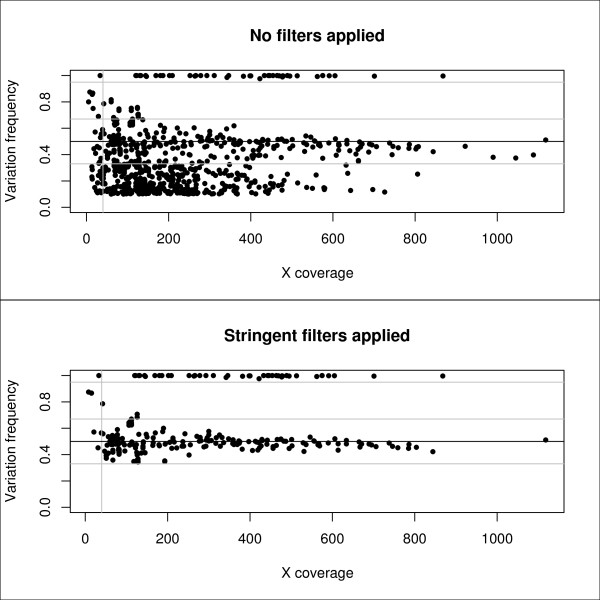
Pre and post filtering variants data. Plot of the coverage (times a single sequence is read by the sequencing equipment) and the frequency of an observed variation. In reality, genomic variation occurs at a frequency of either 50% or 100% of total reads. The top figure is the distribution when no filters are applied to discriminate between sequencing errors and real variants; the bottom figure is the distribution where several filters (frequency filter, Q score filter, coverage filter and homopolymer filter) are applied to discriminate the real variations from the sequencing errors. Vertical grey line indicates 40 × coverage; horizontal grey lines indicate respectively 33%, 67% and 95% variation frequency.